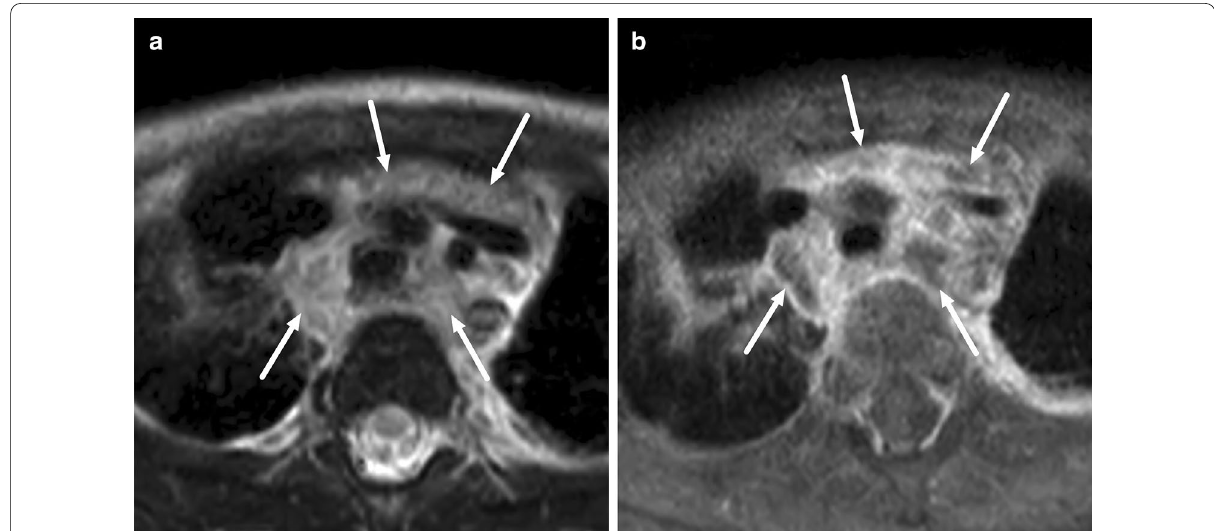
Fig. 28 Mediastinal extension of abscesses (arrows) on axial T2-weighted ( a ) and fat-suppressed post-contrast T1-weighted ( b ) images in an infant. Note the somewhat degraded image quality at this level. The patient underwent thoracoscopy 3 days after MRI because the condition worsened during medical management